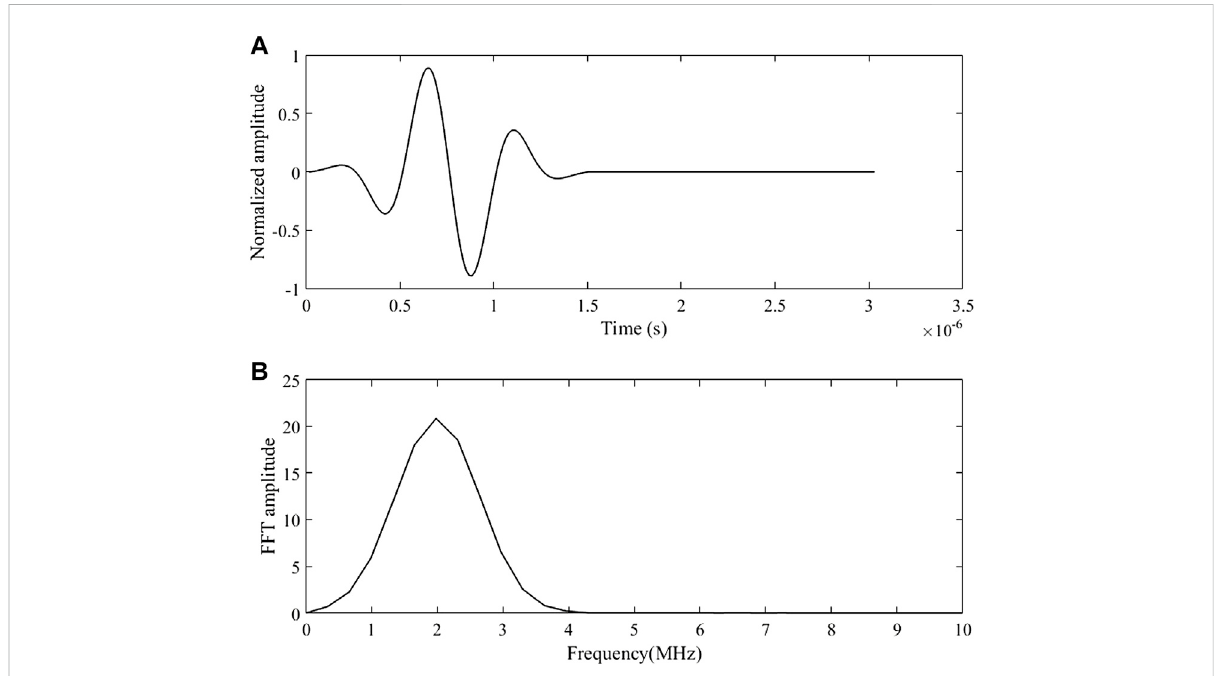
FIGURE 3 The excitation source in (A) time domain (B) frequency